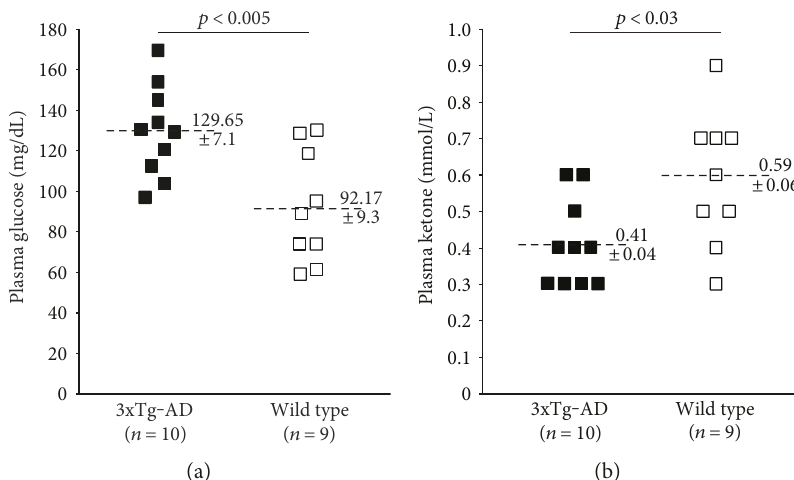
Figure 2: Fasting plasma glucose and ketone levels in 3xTg-AD mice and controls. (a) 3xTg-AD mice exhibited signi fi cantly greater plasma glucose levels compared to controls following a 5-hour fast. (b) 3xTg-AD mice exhibited signi fi cantly lower plasma ketone levels compared to controls following a 5-hour fast.